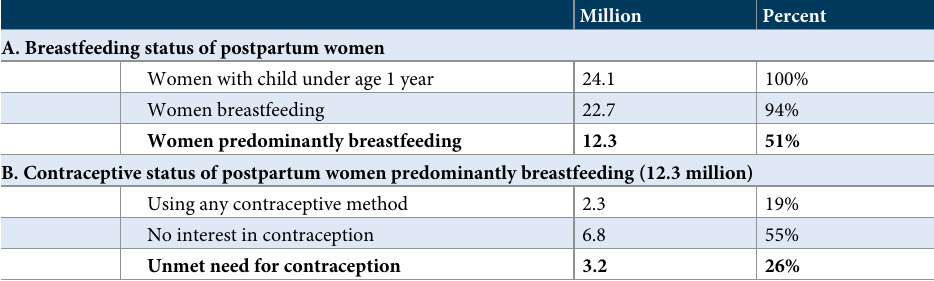
Table 1. Number of women by breastfeeding and contraceptive status, India